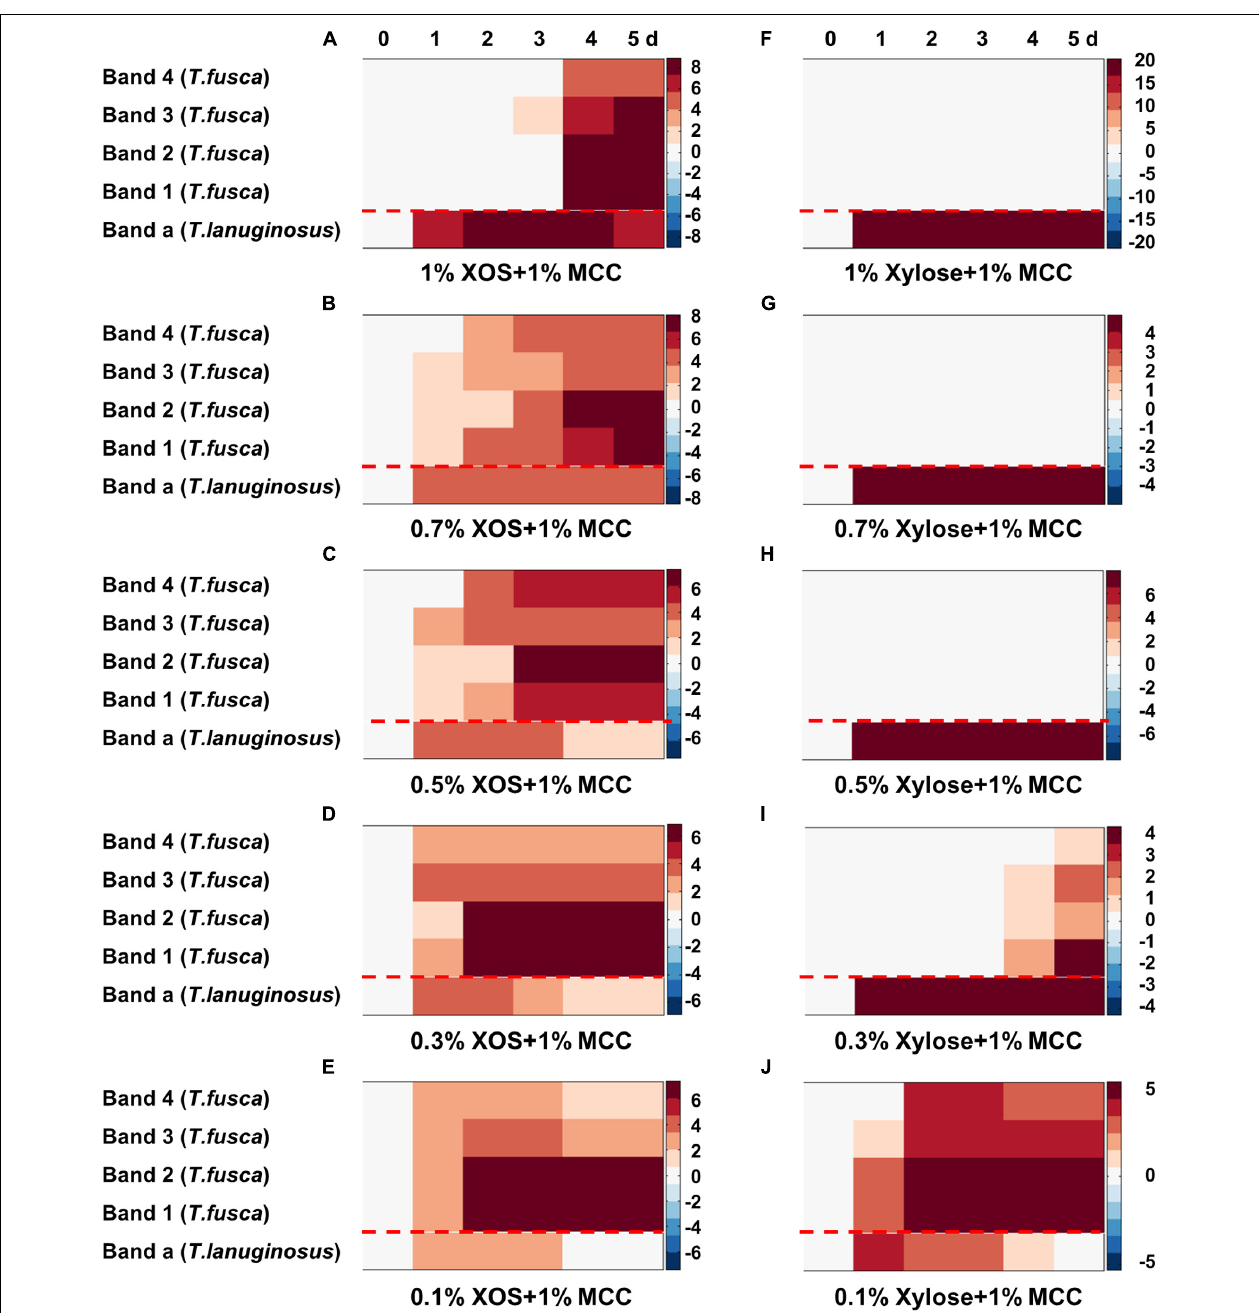
FIGURE 7 | Heatmaps represented the xylanase secretion by T. lanuginosus and T. fusca when they were cocultured on MCC with concentrations of XOS (A–E) or xylose (F–J) ranging from 1 to 0.1% (w/v). Band “ a ” represents band of xylanase secreted by T. lanuginosus . Bands “ 1–4 ” represent bands of xylanases secreted by T. fusca . MCC, microcrystalline cellulose; XOS,